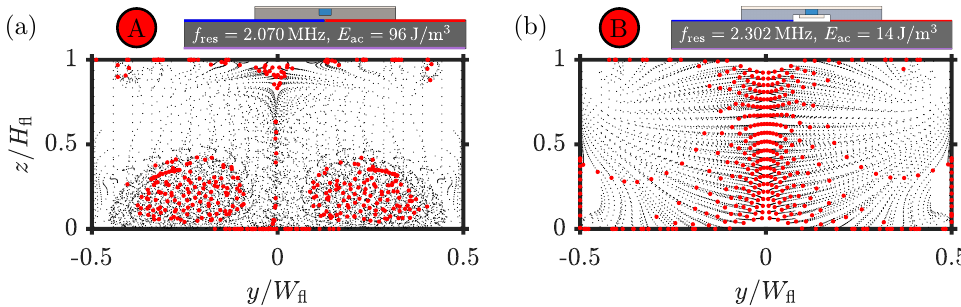
Figure 8. The positions (black dots) of suspended 1-µm-diameter polystyrene particles at discrete time steps from initial time t = 0 to final time t = t focus in anti-symmetrically actuated devices at selected resonance modes. The final positions at time t = t focus are marked by red dots. ( a ) Resonance mode “A” of Figure 5 with E ac = 96 J/m 3 and t focus = 4.3 s with two large vortices extending from the hard bottom aluminum-water interface, two small ones near the PDMS-aluminum corners and poor focusing. ( b ) Resonance mode “B” of Figure 7 with E ac = 14 J/m 3 and t focus = 23.6 s exhibiting four small vortices near the corners and good